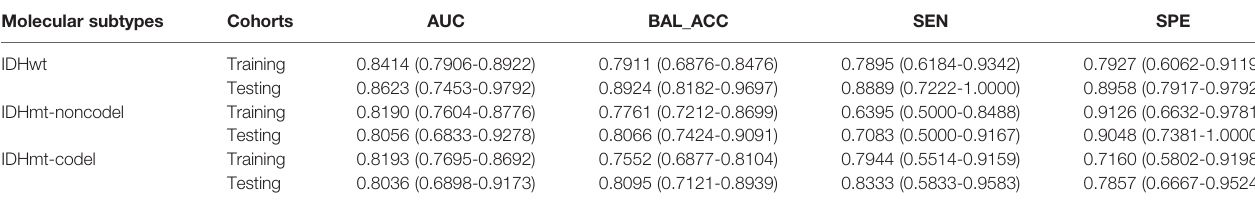
TABLE 4 | Summary of the subtype-speci fi c classi fi cation performance of the combined model. Molecular